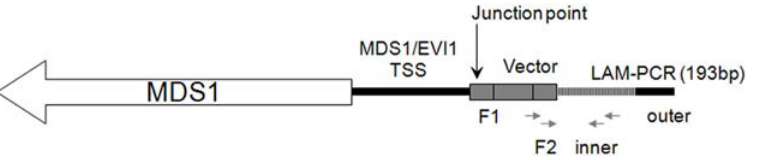
Figure 3. Location of the RIS identified upstream of the MDS1/EVI1 TSS. The black arrowed indicate the insertion site at chromosome 3(q26.2) position 170865174 which is 1006 bp upstream of the TSS. The black vertical arrow is junction point of our vector to TSS (position 170865174). The vertical stripes section shows the 193 bp where our sequence was detected by LAM-PCR. The gray arrows are vector specific PCR primers (F1-outer, F2-inner) to confirm the insertion.